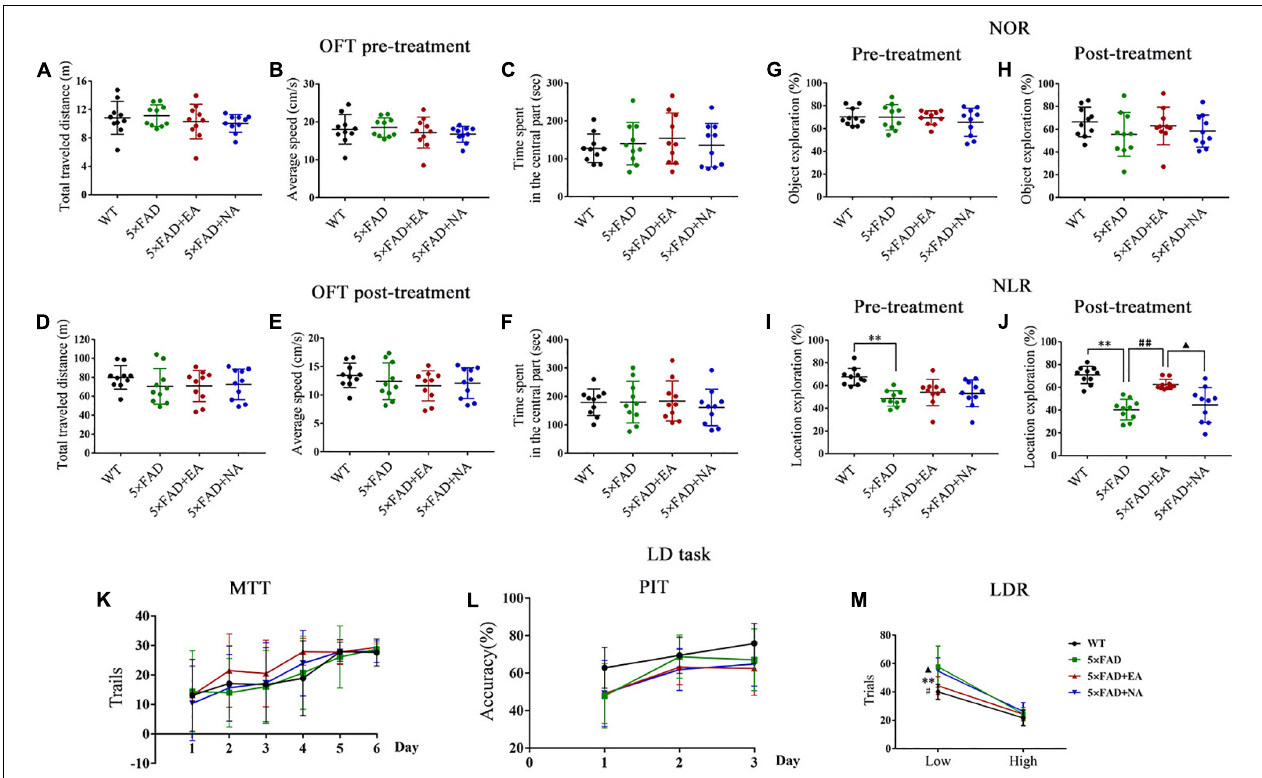
FIGURE 3 | Electro-acupuncture (EA) treatment improves spatial recognition memory and pattern separation impairment in 5 × FAD mice. Results of the open field test (OFT) are expressed as a total traveled distance (A,D), average speed (B,E) and time spent in the central part (C,F) pre and post-treatment ( n = 10/group). Exploration of mice during novel object recognition (NOR) (G,H) and novel location recognition (NLR) (I,J) learning paradigms ( n = 10/group). Results of LD task are expressed as trails of must touch training (MTT) (K) , accuracy of punish incorrect training (PIT) (L) and trails of location discrimination reversal (LDR) (M) ( n = 8/group). Data are represented as mean ± SD. Each circle represents a mouse (** p < 0.01 vs WT group; # p < 0.05 and ## p < 0.01 vs 5 × FAD group; (cid:78) p < 0.05 vs 5 × FAD + EA